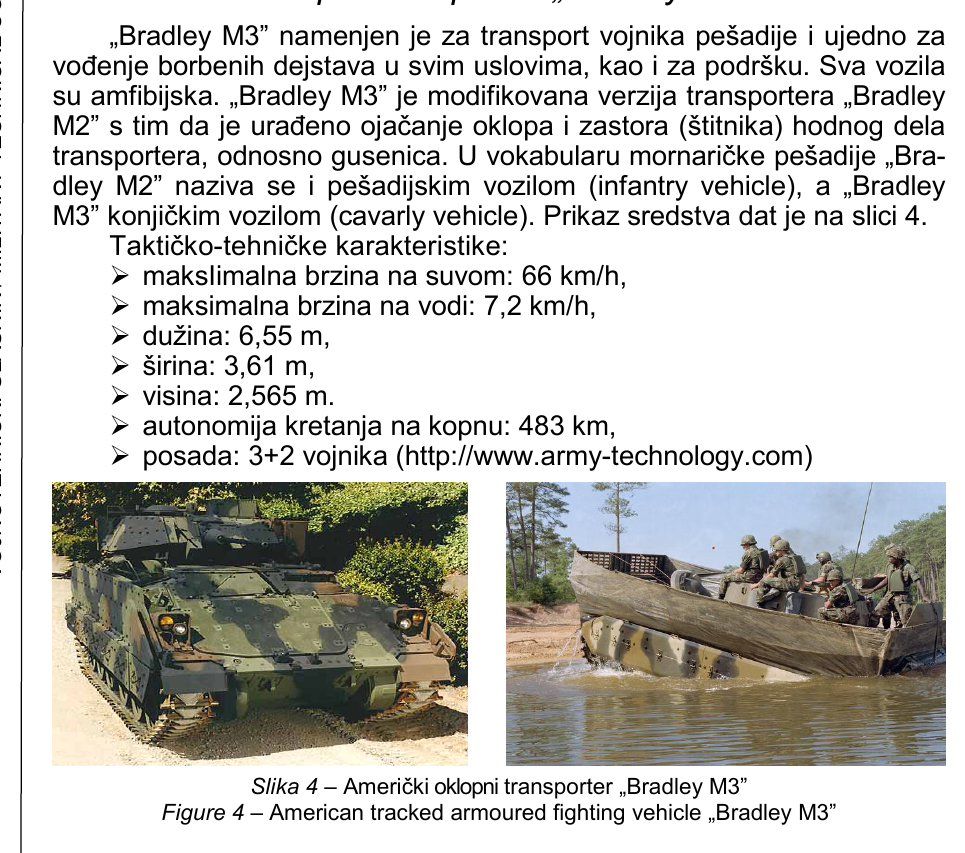
Figure 4 – American tracked armoured fighting vehicle „Bradley